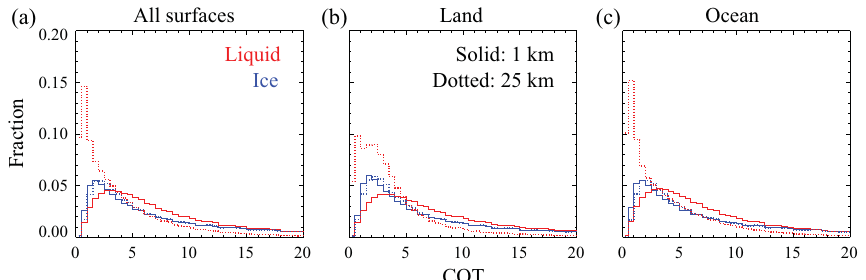
Figure 12. Histograms of single-channel COT retrievals at the native 1km (at nadir) MODIS resolution (solid lines) and 25km (at nadir) resolution (dotted lines) for liquid (red lines) and ice (blue lines) phase clouds for the entire April 2005 Aqua MODIS subset. Note these histograms include only those scenes for which the cloudy 1km pixels within each 25km pixel have the same cloud phase as that of the 25km